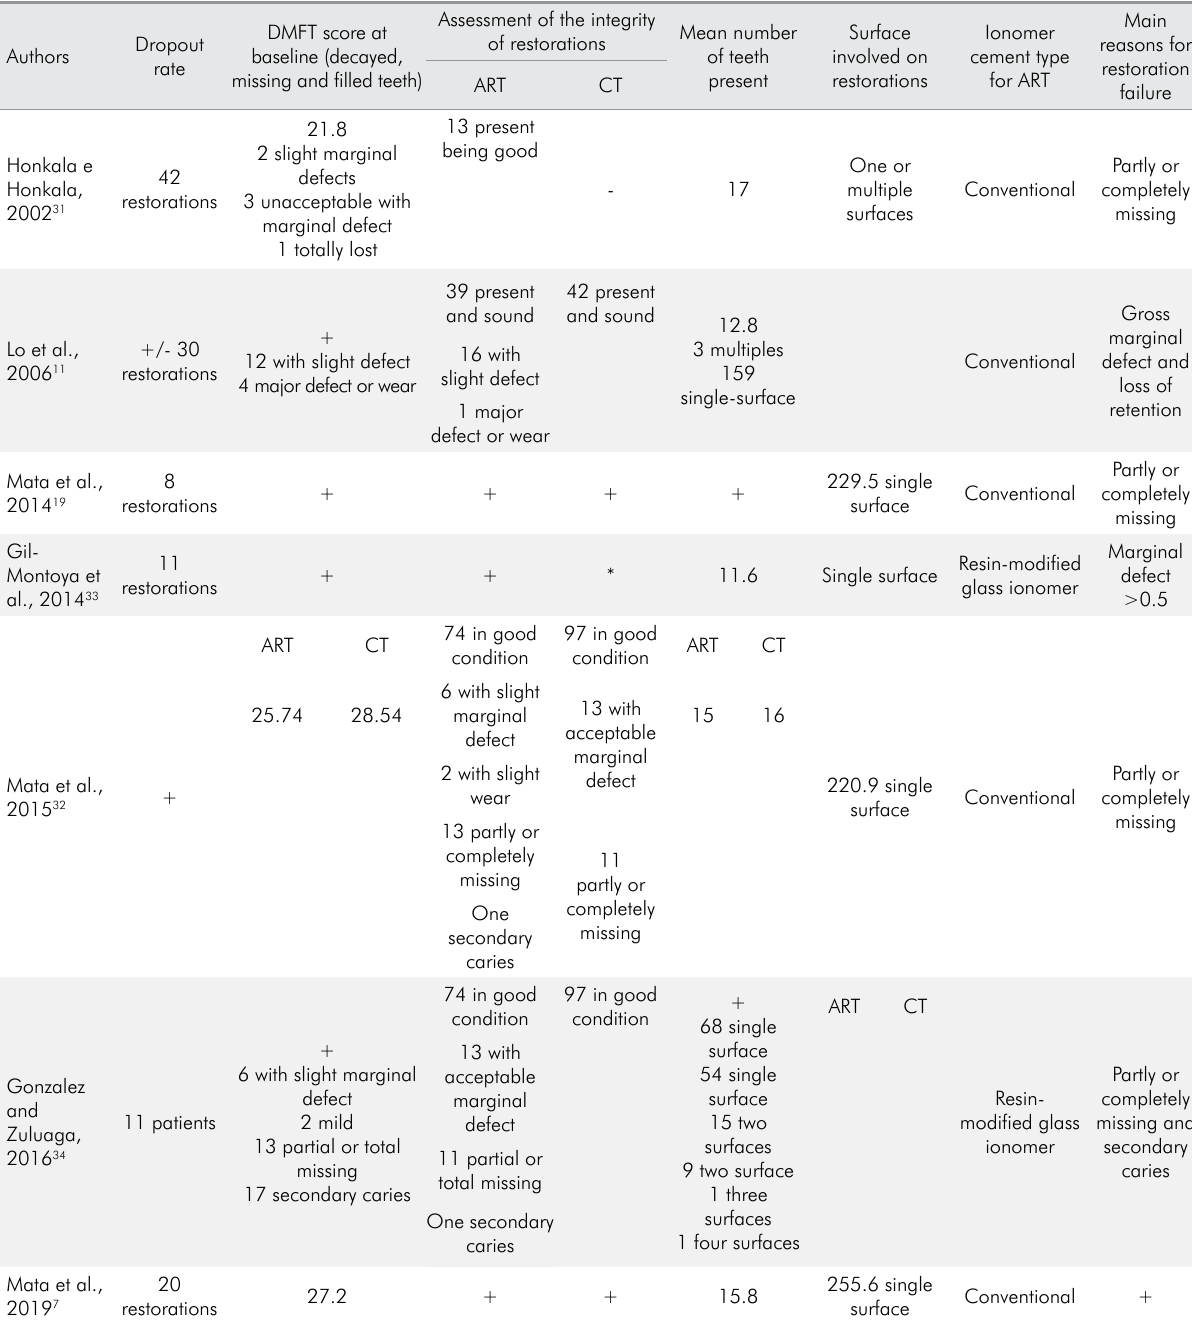
Table 5. Other outcomes of included